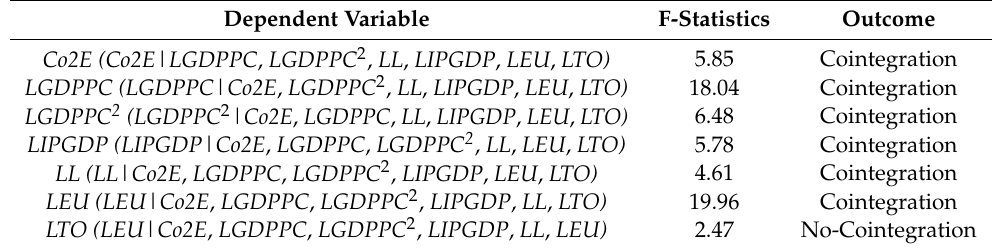
Table 2. Normalization Results from Bounds